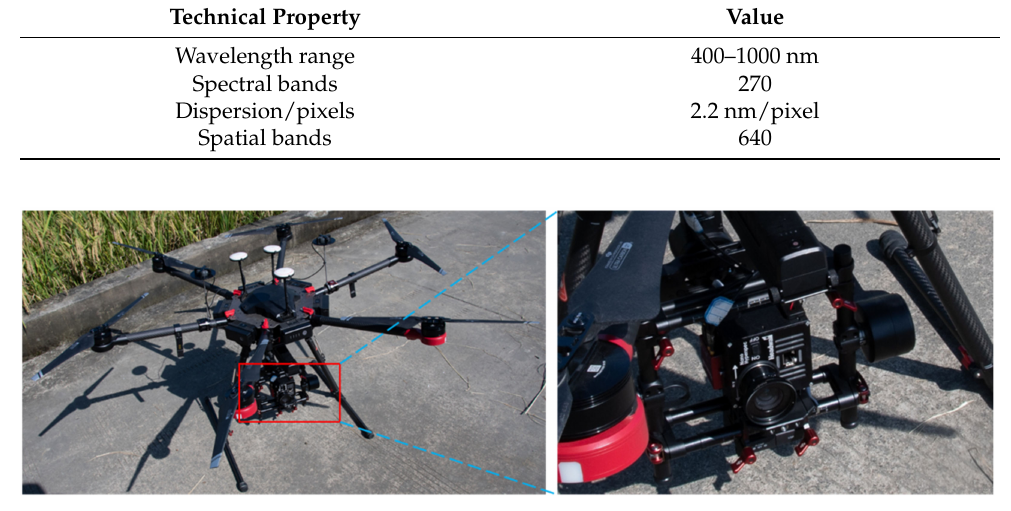
Figure 1. UAV imaging system. Table 2. Specifications of four UAV campaigns in this